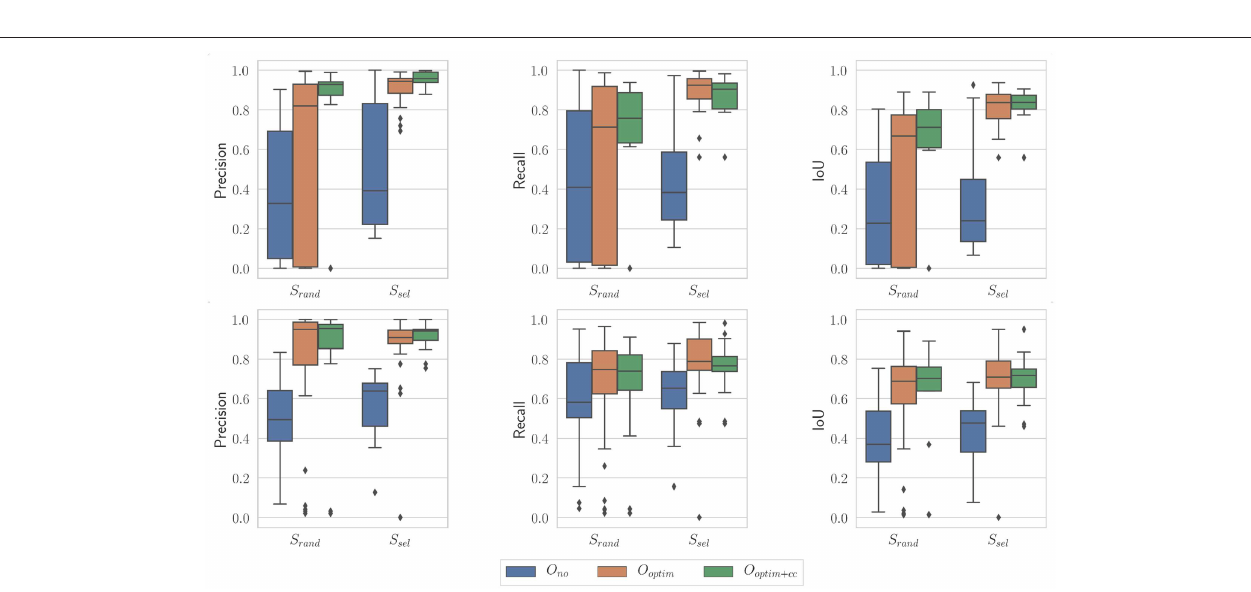
FIGURE 12 | 3D scatter plots representing the position of the swarm particles in the search space at the end of the optimization (on a single image, without consistency check), for the different PSO parameters. The colors represent associated cost function values. (Top) In vivo dataset; (Bottom) Benchtop dataset. The three axes are the three components of δ : the bending curvature [ m − 1 ], the robot rotation [ rad ], and the robot insertion [ mm ].